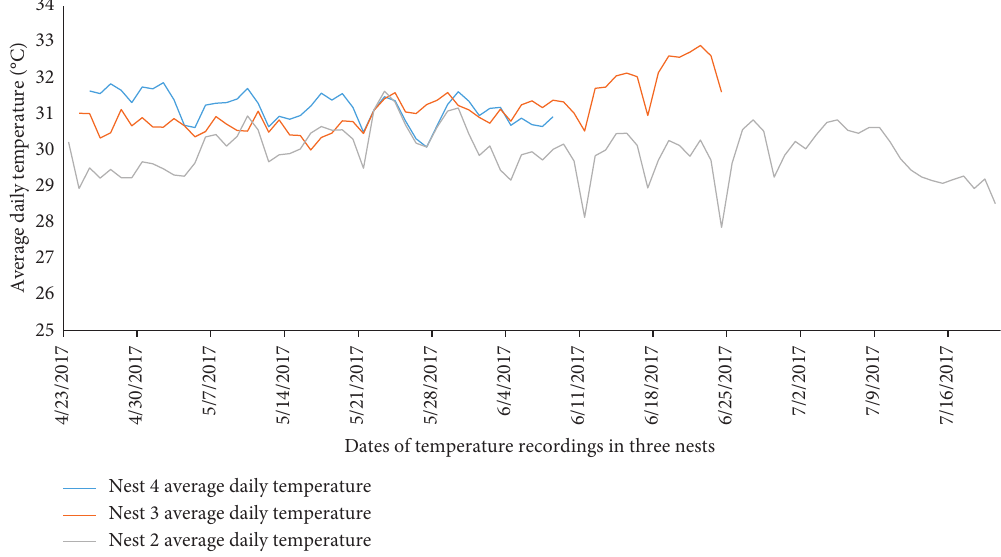
Figure 2: Daily mean temperature variation trends in three nests. The plot on the graph ended on different dates because the number of days temperature was monitored was different for each